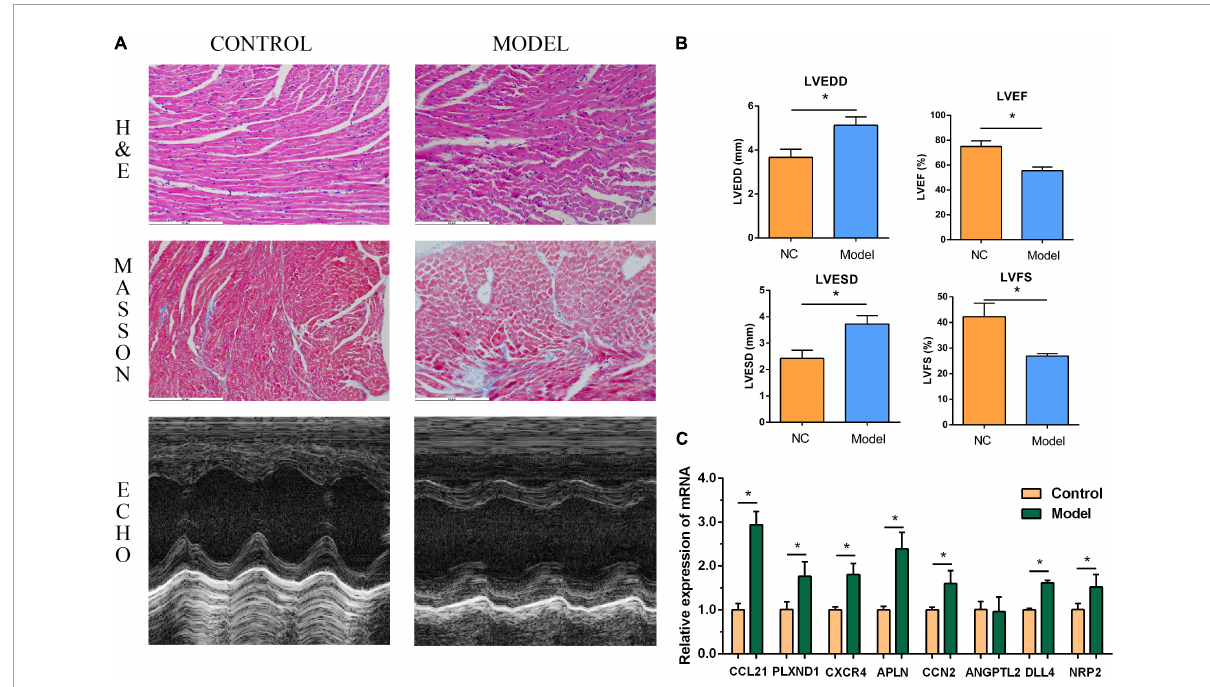
FIGURE8 Myocardial injury and impaired heart function were assessed in Type 1 diabetic heart failure mice model. (A) Representative pictures of HE staining, Masson staining, and echocardiography (magnification, 400 × ). (B) Comparison of LVEDS, LVEDD, LVEF, and LVFS between the control group and the model group. (C) Relative mRNA expression of each core gene in control group and model group. * P <